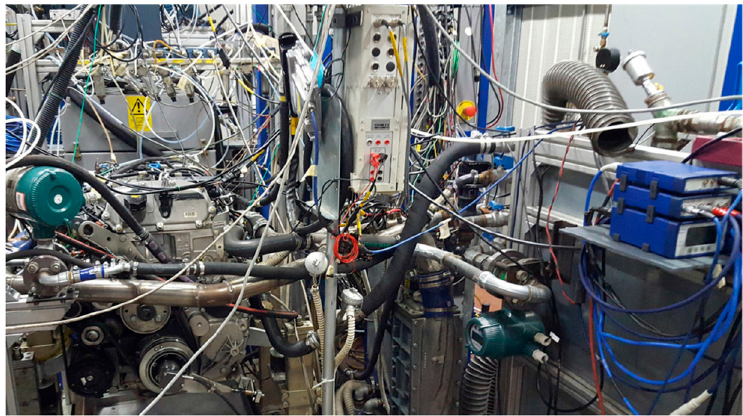
Figure 1. Picture of the FPT F1C 3.0 L Euro VI diesel engine installed at the Politecnico di Torino. The rapid prototyping device is located on the right side.